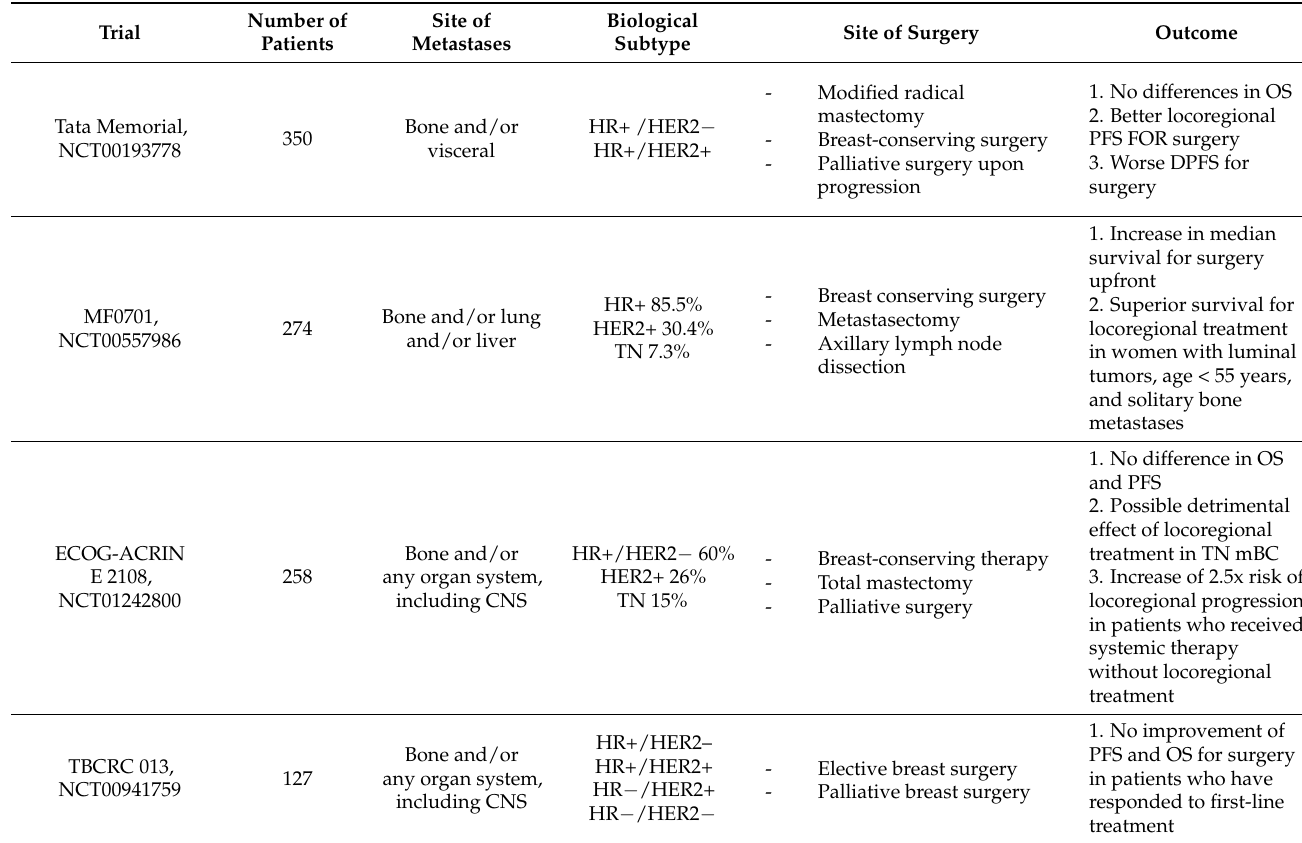
Table 1. Randomized trials that evaluate the efficacy of surgery in